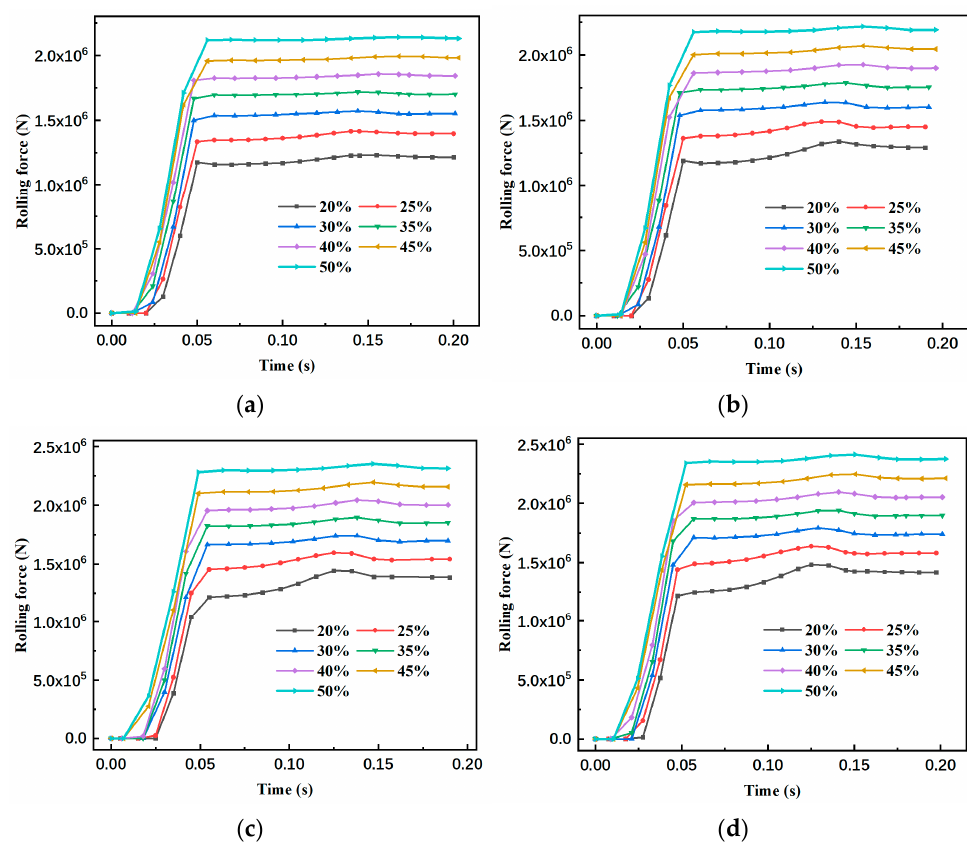
Figure 5. Variations of rolling force vs. rolling time obtained at different reduction ratios of the clad plate. ( a ) Thickness ratio = 0.11, ( b ) thickness ratio = 0.25, ( c ) thickness ratio = 0.67, ( d ) thickness ratio = 1.0.